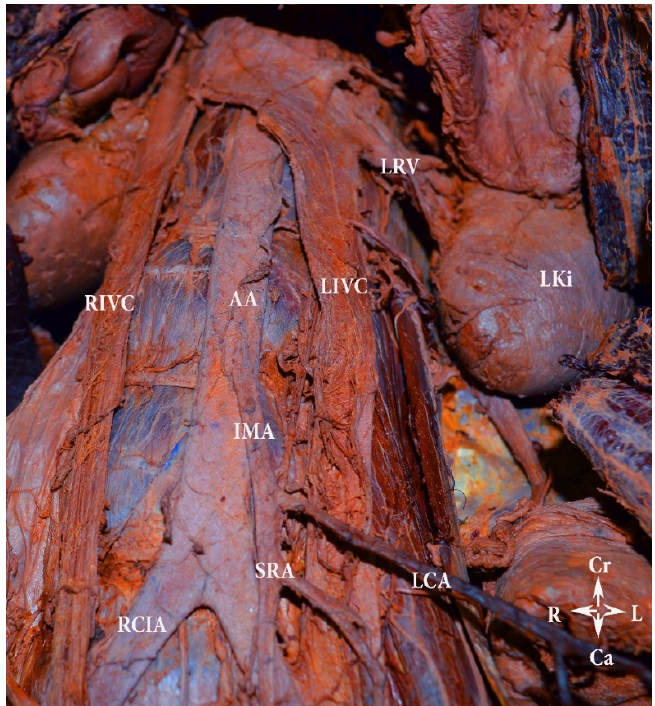
Figure 20. Bilateral duplication of the inferior vena cava with no communication between veins (embalmed cadaver). Type IVA according to our classification. LIVC—left inferior vena cava, RIVC—right inferior vena cava, AA—abdominal aorta, LCA—left colic artery, SRA—superior rectal artery, IMA—inferior mesenteric artery, RCIA—right common iliac artery, LRV—left renal vein, LKi—left kidney, Cr—cranial, Ca—caudal, L—left, R—right.